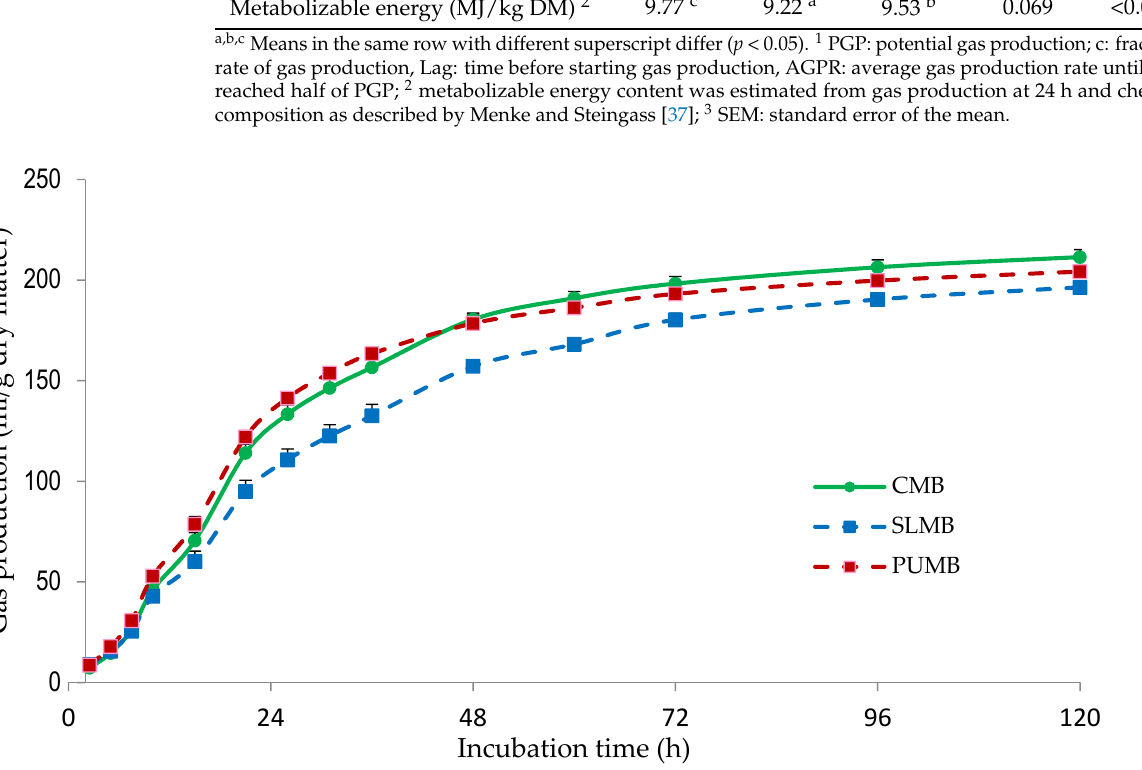
Figure 3. Gas production kinetics of multinutrient blocks without including seaweeds (CMB; control) and including Saccharina latissima (SLMB) or Porphyra umbilicalis (PUMB). The bars indicate the standard error of the mean (n = 16).